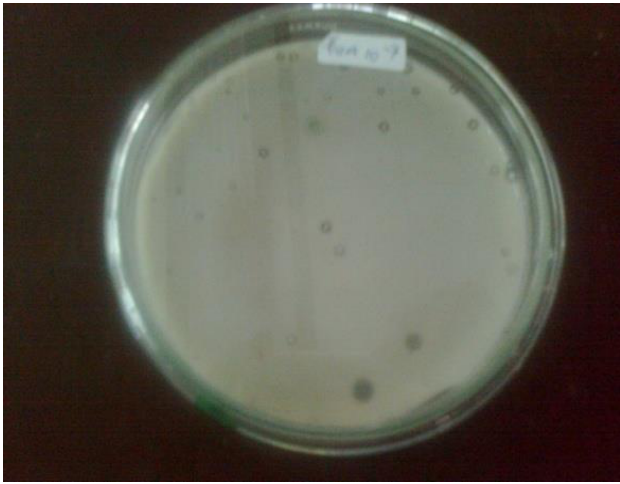
Figure 2. Result of lactid acid bacteria isolation from coconut oil and from palm oil with no evidence of growth.